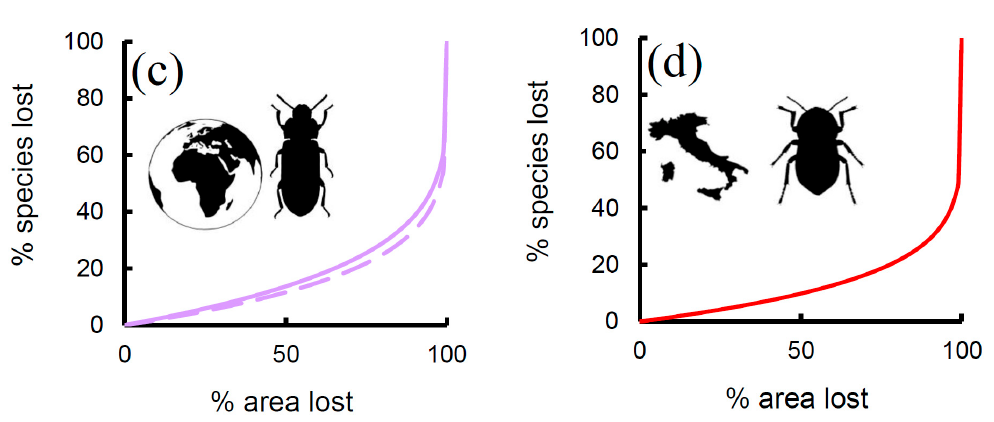
Figure 6. Extinction rates (% of extinct species) expected on the basis of area loss (% of area lost) for tenebrionids in Italian reserves. ( a ) geophilous species, ( b ) xylophilous species, ( c ) widespread species, ( d ) endemic species. Solid lines: expected rates from the species-area relationship. Dashed lines: expected rates from multiple regression models. In panel ( a ) the two dashed lines refer to calculations based on two exponents: 0.187 (upper) and 0.104 (lower). Lack of dashed lines in panels ( b , d ) is because the best-fit multiple models included only area.